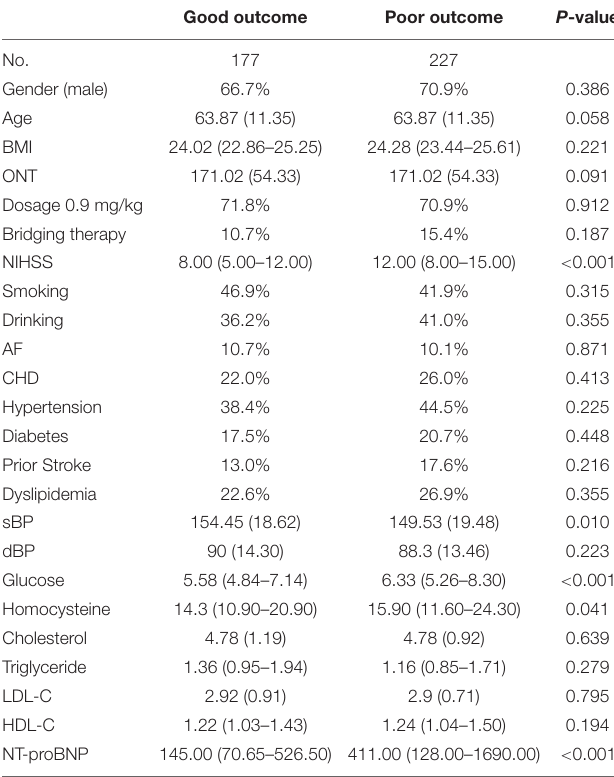
TABLE 1 | Characteristics of included